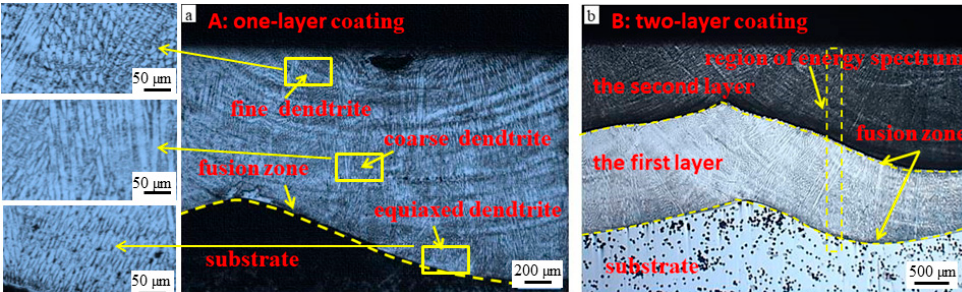
Figure 3. Optical micrographs of coatings A and B and the region and direction of energy spec- trum analysis. ( a ) is the optical micrograph of coating A. ( b ) is the optical micrograph of coating